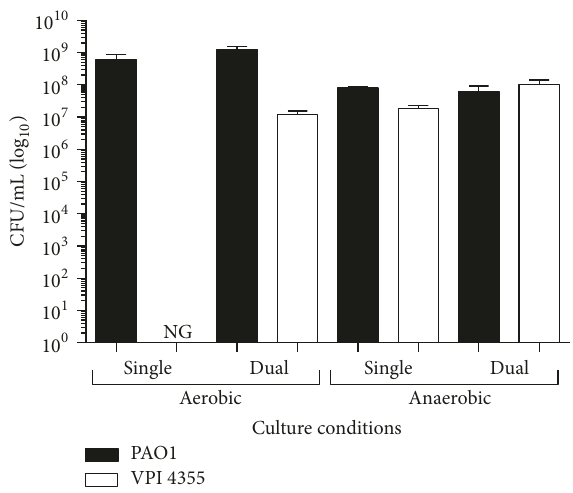
Figure 3: P. aeruginosa supports the growth of F. nucleatum under aerobic conditions. P. aeruginosa strain PAO1 and F. nucleatum strain VPI 4355 were inoculated into BHI broth individually or in coculture and incubated at 37 ∘ C under aerobic or anaerobic condi- tions. The number of CFU/mL was determined. Values represent the means of three independent experiments ±